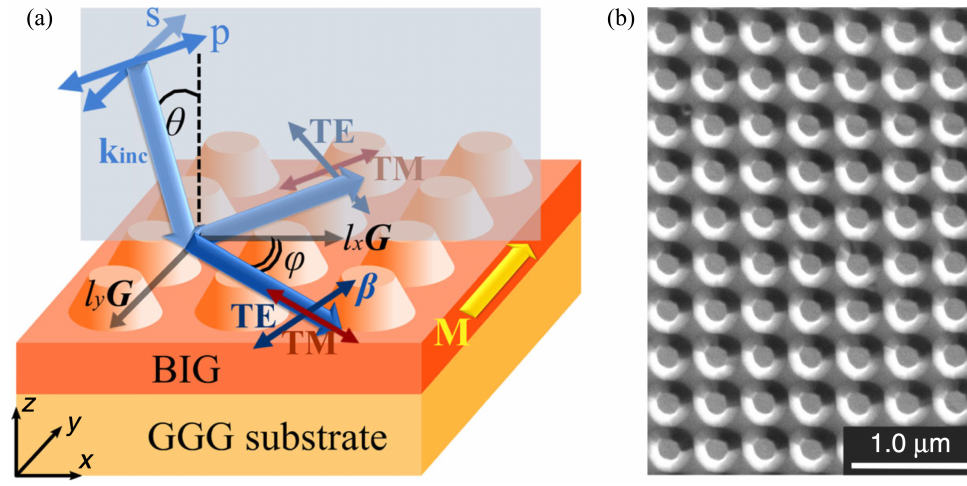
Figure 7. ( a ) Schematic of the metasurface and mode excitation. ( b ) SEM picture of the fabricated microstructure. Adapted with permission from ref. [33]. Copyright 2020 Springer Nature.